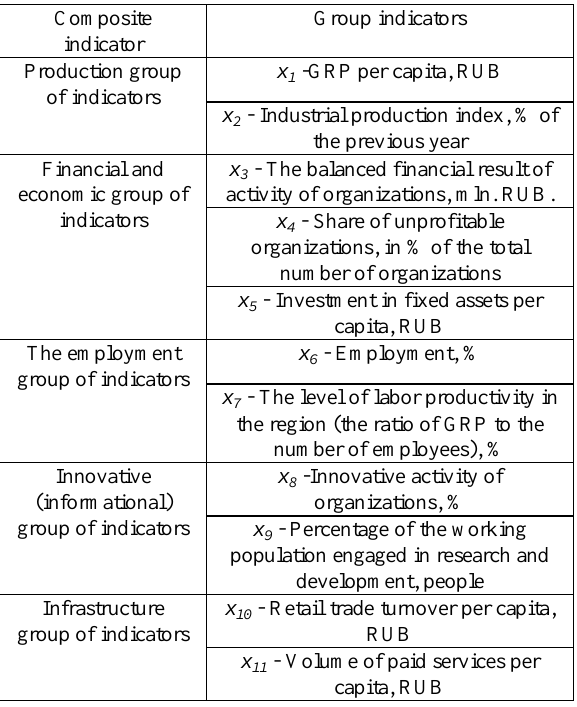
Table 1. Grouping of indicators used to analyze